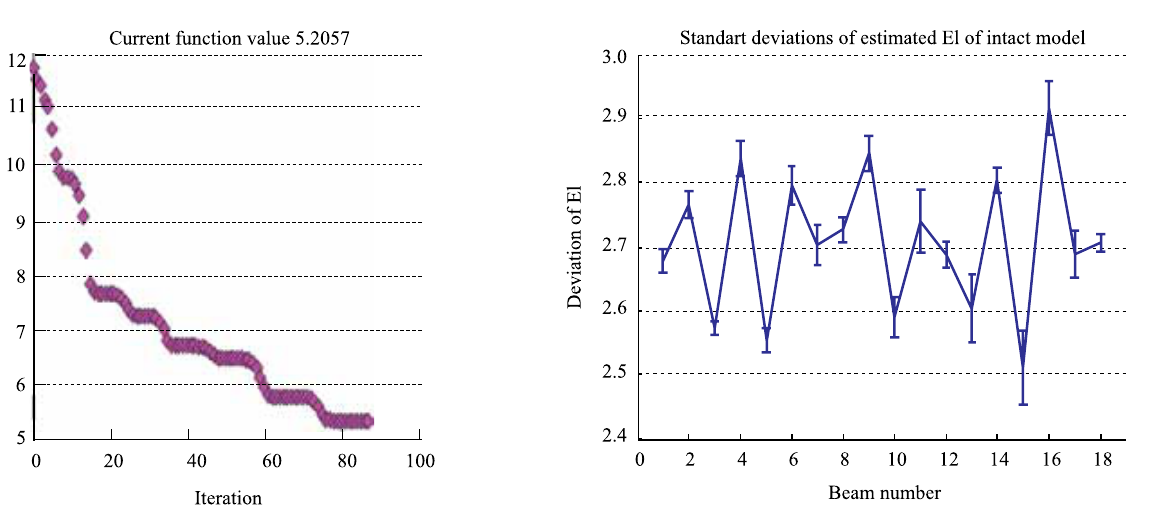
Fig. 7. The cost function values during optimization process